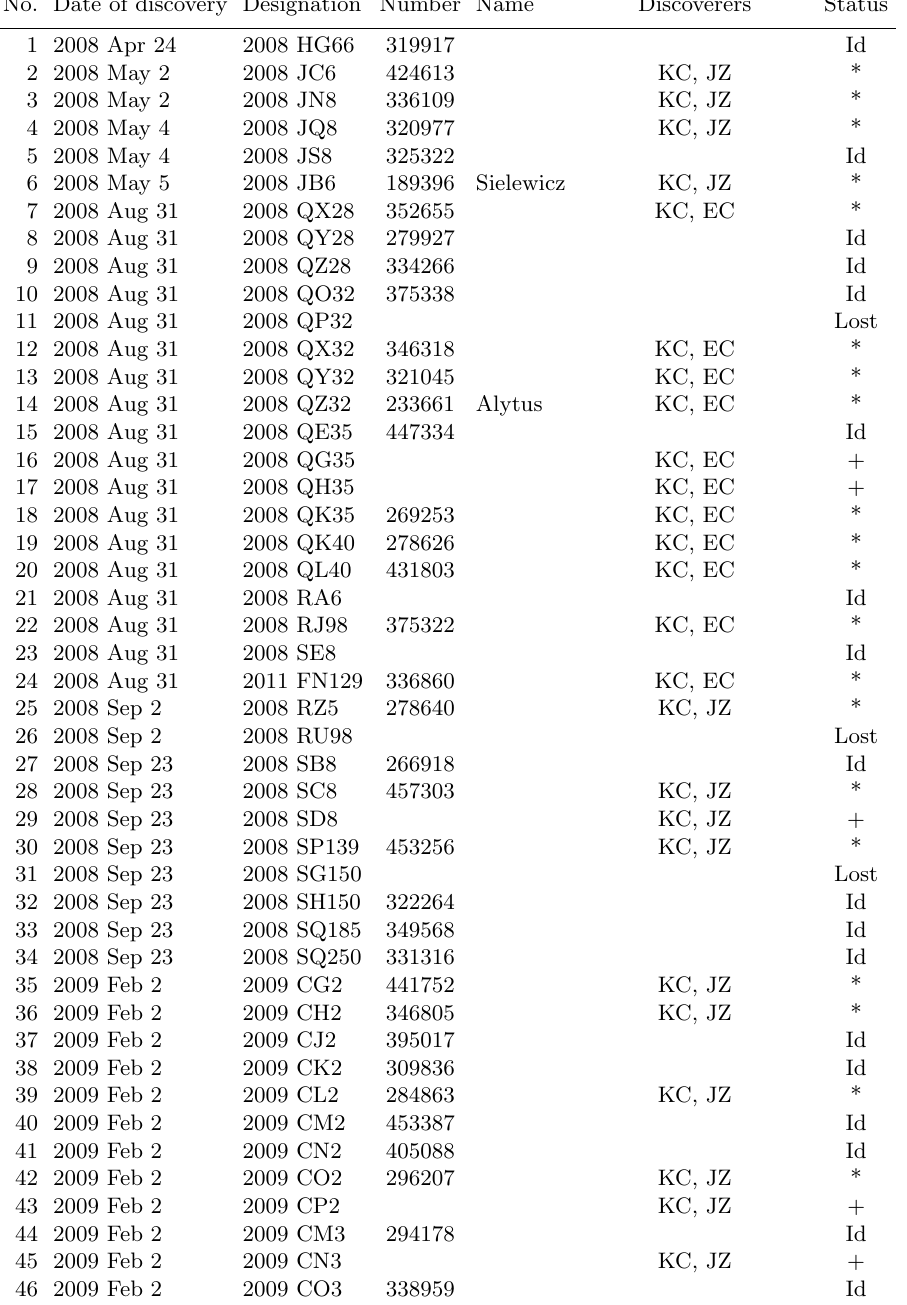
Table 2. List of asteroids discovered at the Mol˙etai Observatory in